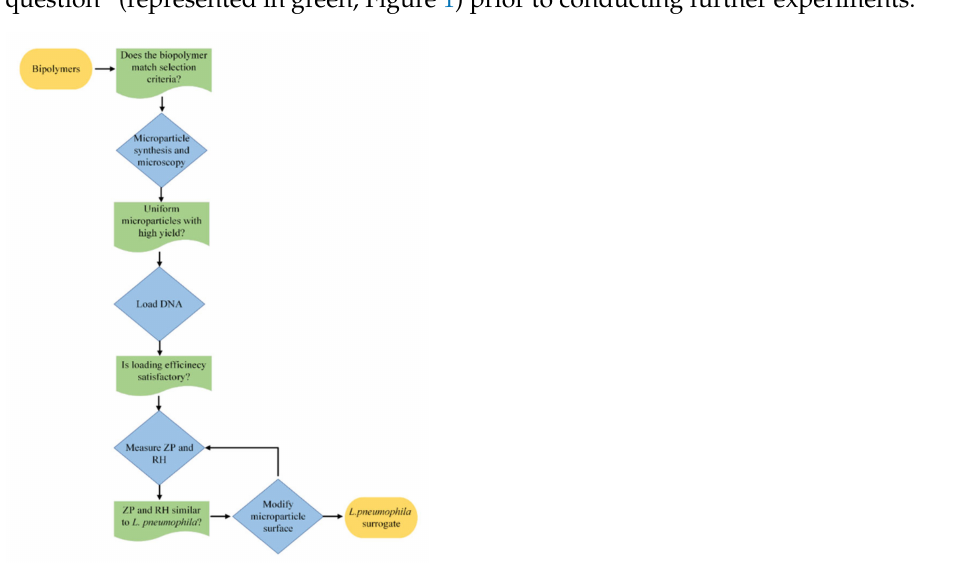
Figure 1. Stepwise approach to surrogate synthesis and modification. ZP: zeta potential; RH: relative